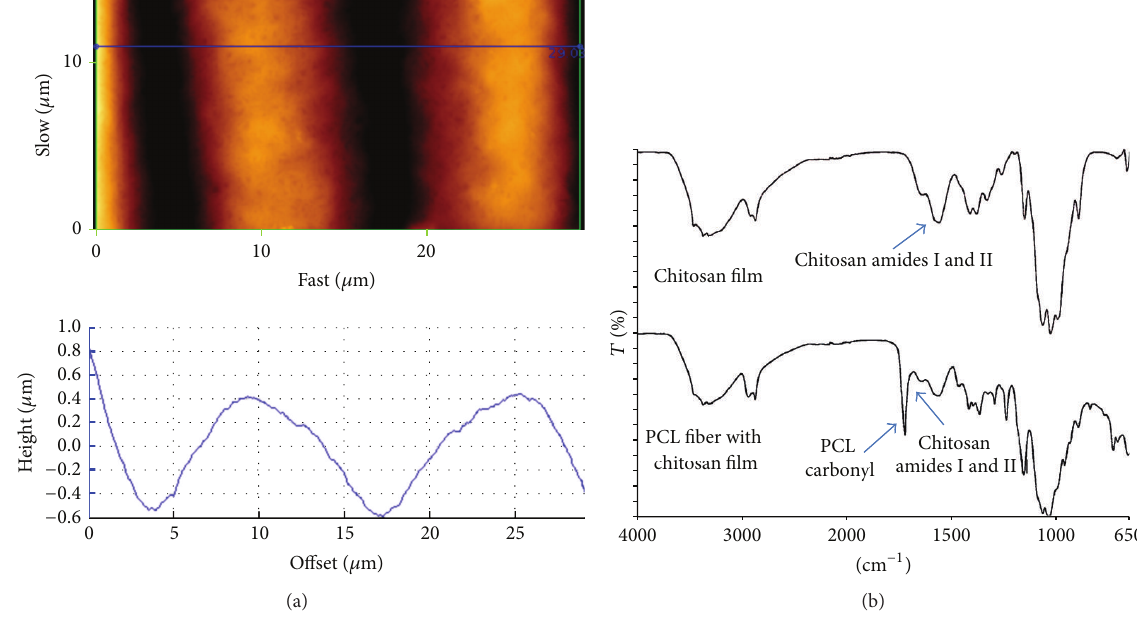
Figure 2: Surface analysis of the aligned chitosan covered fibers: AFM of fibers bonded by chitosan (a). FTIR of the chitosan film and PCL coated chitosan